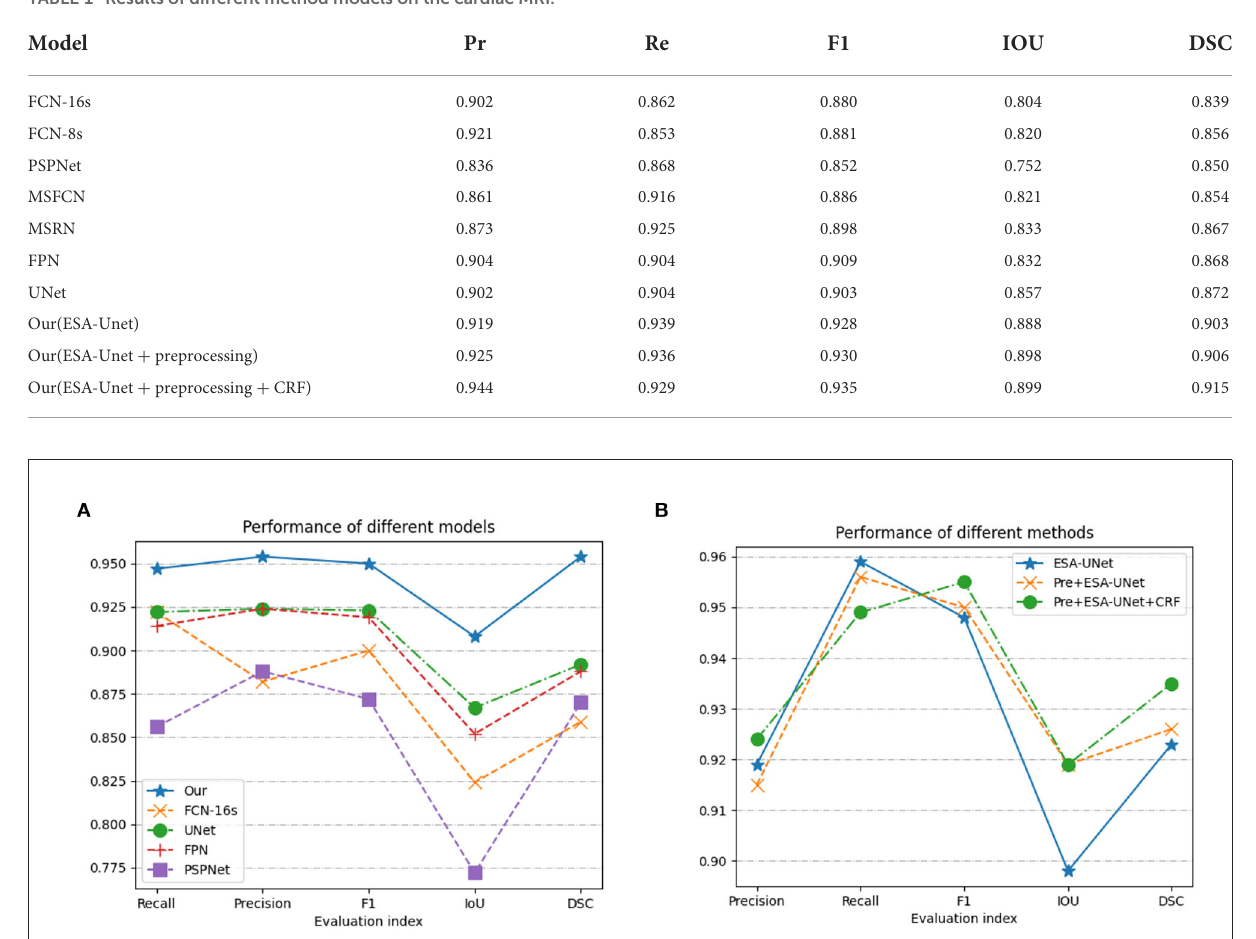
TABLE 1 Results of different method models on the cardiac MRI.